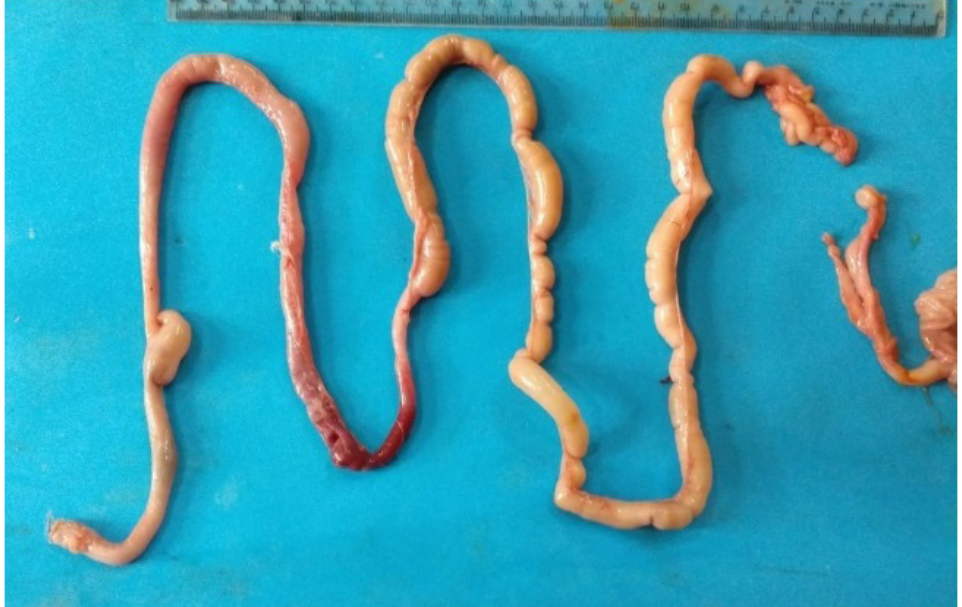
Figure 2. Macroscopic aspect of the small intestine (duodenum, jejunum and ileum) of the patient after undoing the ileo-ileum intussusception showing congestion and necrosis in the serosa of the invaginated